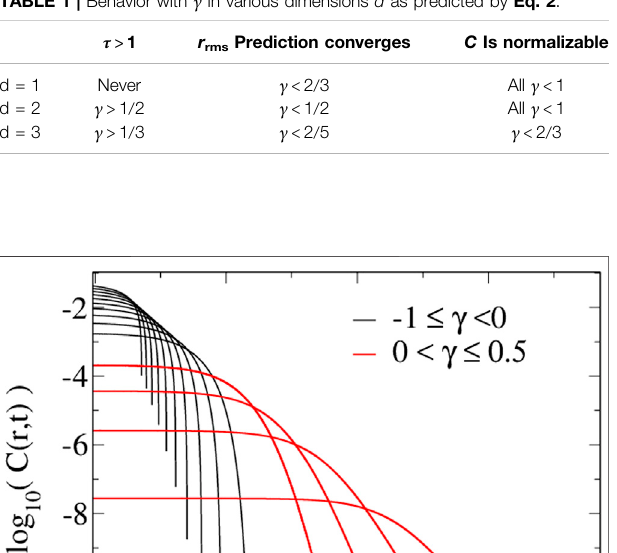
TABLE 1 | Behavior with γ in various dimensions d as predicted by Eq. 2 .